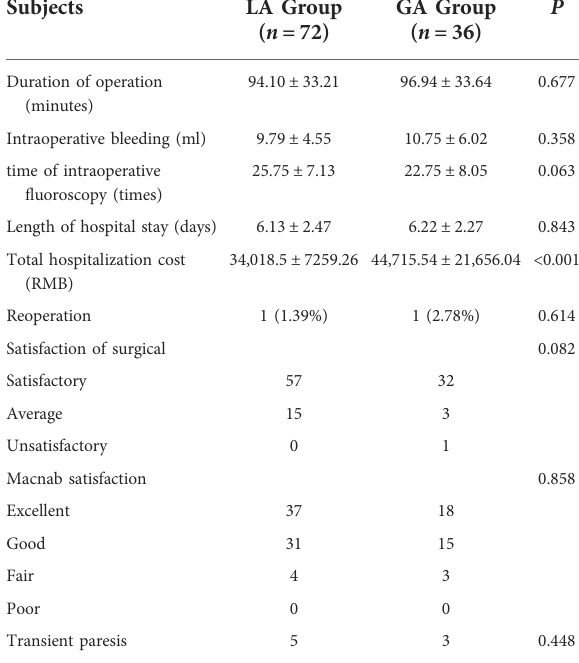
TABLE 2 Comparison of clinical outcomes between the two